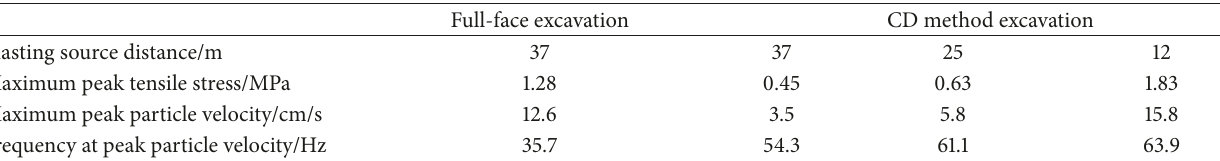
Table 4: Dynamic response on NBBT lining induced by